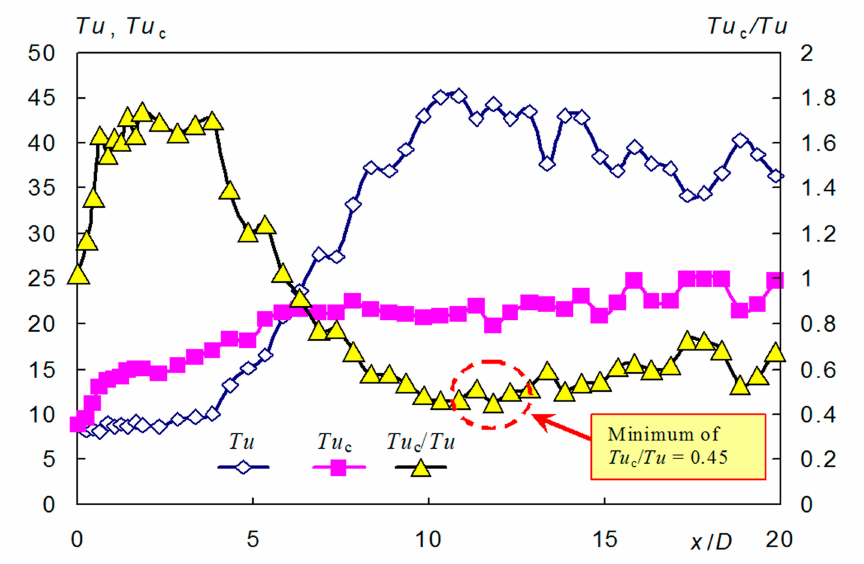
Figure 6. Development of the intensity of turbulence along the axis for Re = 2555 for unforced ( Tu ) and forced ( Tu c )